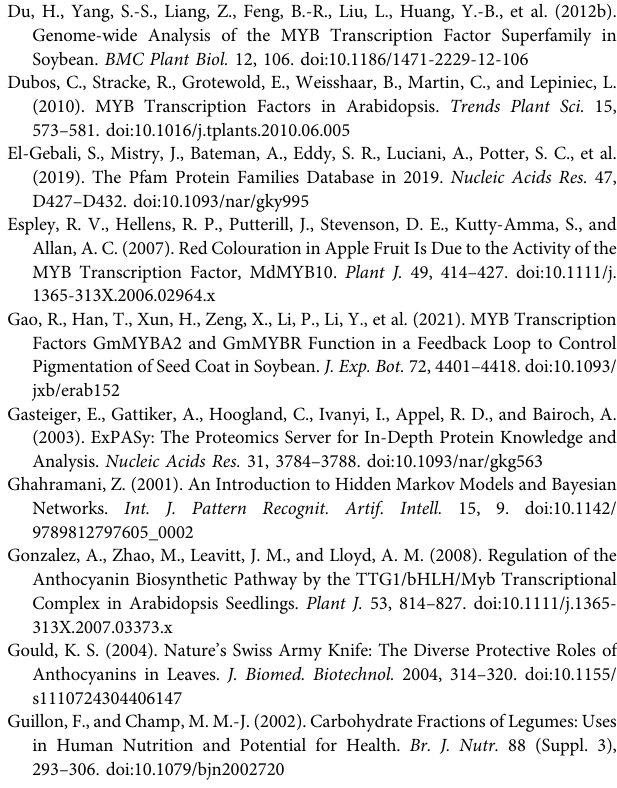
Supplementary Figure S1 | Conserved Motifs and predicted structures of R2R3- MYB genes in pea. Supplementary Figure S2 | Multiple alignment of R2R3-MYB domains of 119 pea R2R3-MYB proteins. ClustalW amino acid sequence alignment. The black arrowheads at the top indicate the conserved tryptophan (W) or phenylalanine (F) residues. Red letters represent proteins with incomplete R2 domains. Position numbers at the top correspond to those given in Figure 2 . Supplementary Figure S3 | The expression pattern of PsbHLH. (A) Heat-map showing the expression level of PsbHLH under different nutritive conditions and different stages based on RNA-seq data. Normalized log2 transformed values were used with hierarchical clustering represented by the color scale ( − 9 – 8). Green indicates low expression, and red indicates high expression. HN, High N (14 mM N). LN, Low N (0.625 mM N). (B) The expression pro fi les of PsbHLH during fl ower development were con fi rmed using qRT-PCR. The data are the mean ±SD from three biological replicates. Dp, Dorsal petals; Lp, Lateral petals; Vp, Ventral